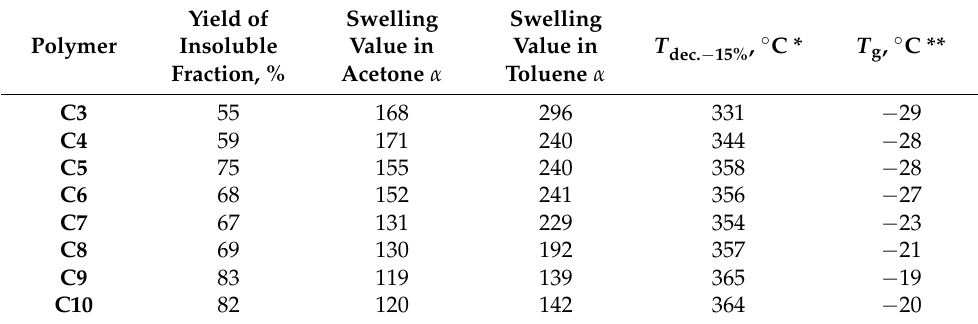
Table 3. Yield of insoluble fraction, swelling values, and thermal properties of photopolymers